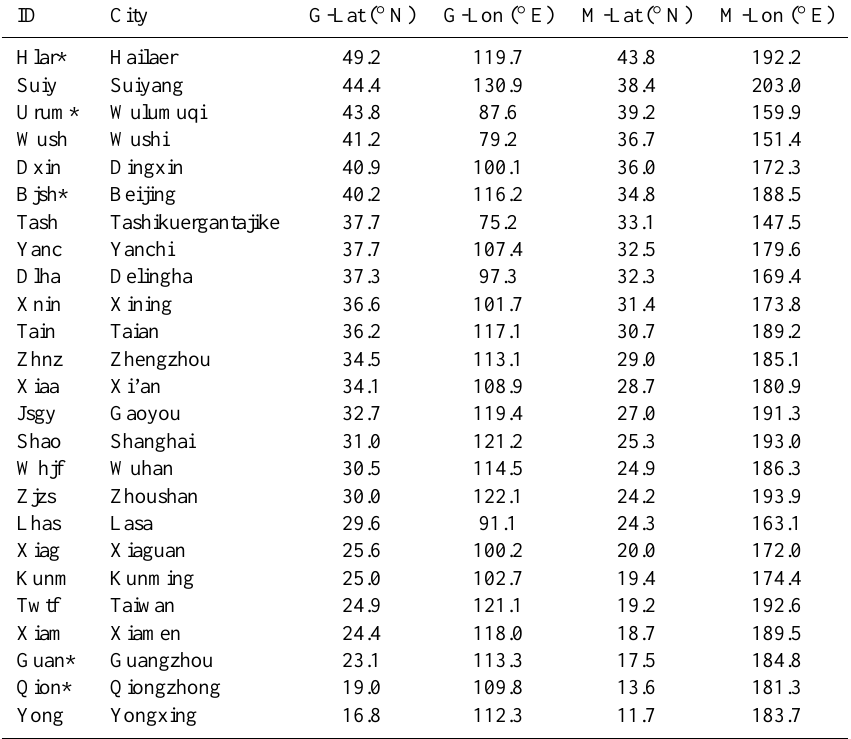
Table 1. Information on the GPS sites and ionosondes used in this work.